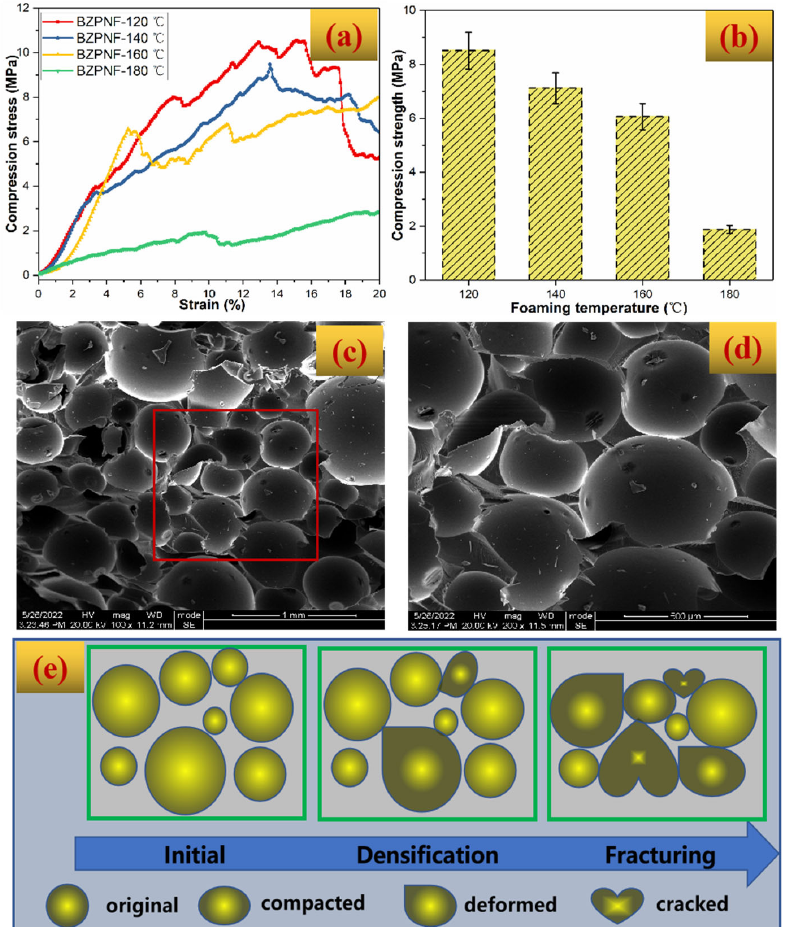
Figure 6. ( a ) Stress–strain curve, ( b ) compressive strength, ( c , d ) SEM images after compression test, and and ( e ) fracture mechanism of BZPN foam. and and ( e ) fracture mechanism of BZPN